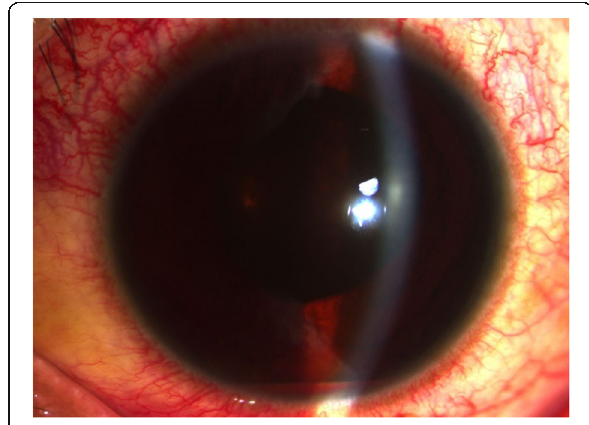
Fig. 3 On Day 8 post-laser, four days following subconjunctival injection of triamcinolone acetonide, 10mg, hypopyon is seen reduced, with a marginally decreased anterior chamber cell and flare